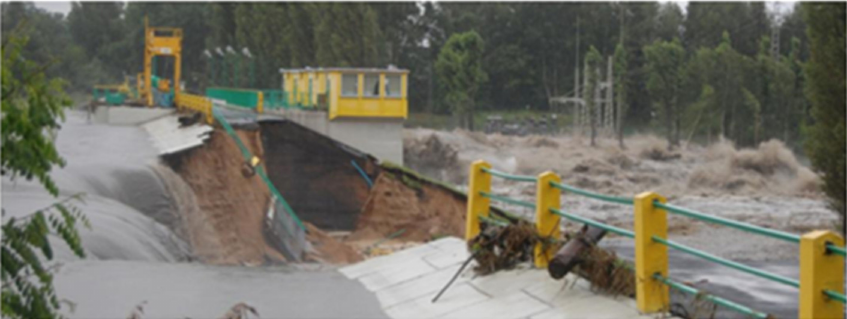
Figure 7. View from the right bank on 7 August 2010, time 18:22. Behind the concrete structure, an immense outflow is visible after the abutment had collapsed. Water level in the reservoir ca.